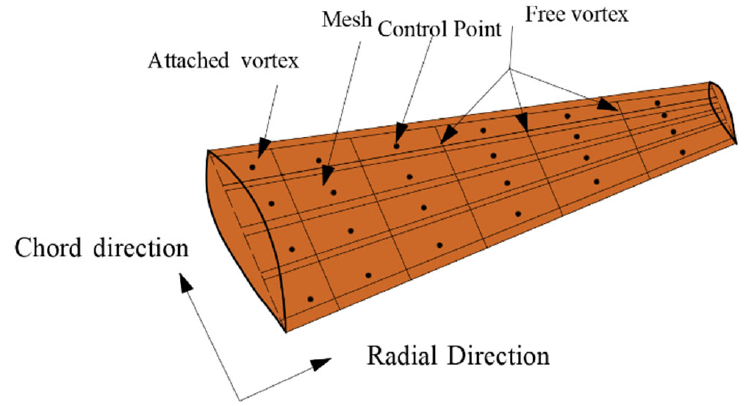
Figure 7. Vortex lattice distribution of blade lifting surface.